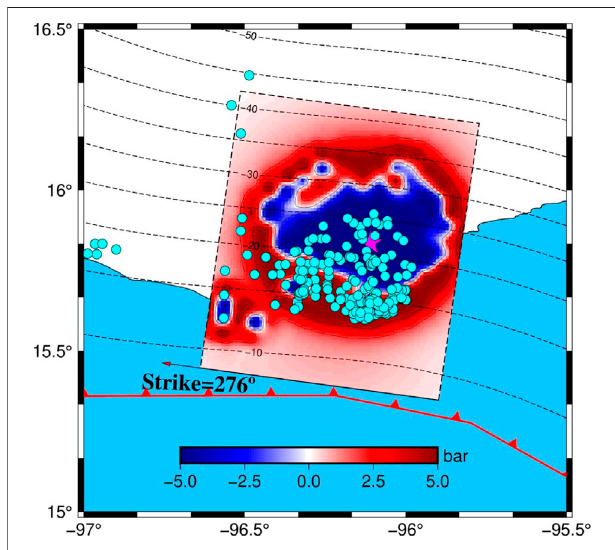
FIGURE 13 | Coulomb failure stress change on the fault plane; the cyan circledenotestheaftershockdistributionamonthafterearthquakeorigintime, which the depth small than 20 km. The magenta star denotes the